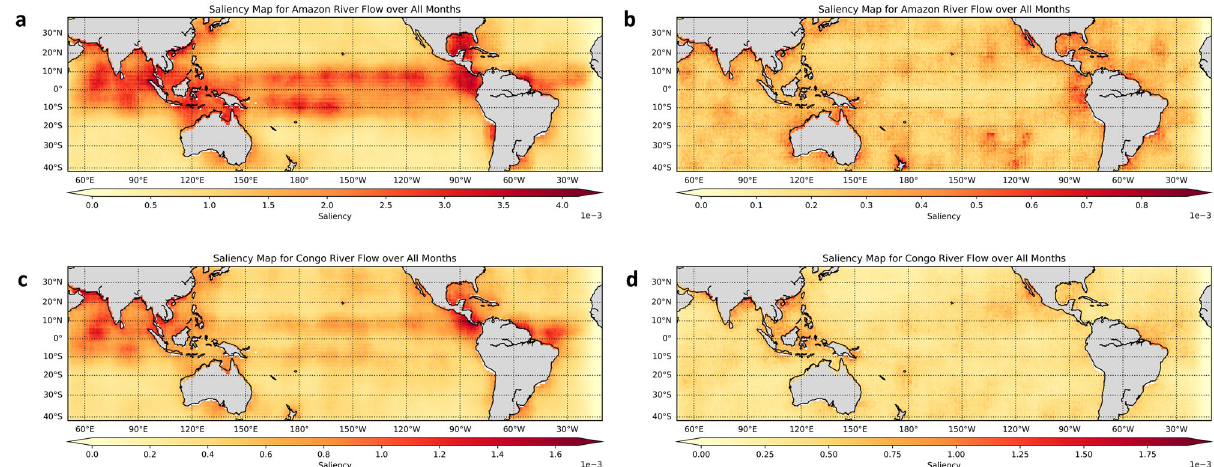
fl owpredictionusingESMs( c )andreanalysis( d )SST,respectively.WhenusingESM SSTaspredictor,thesalientareasmainlylieinthetropicalPaci fi candIndianOcean, but they are much more diffused when using reanalysis